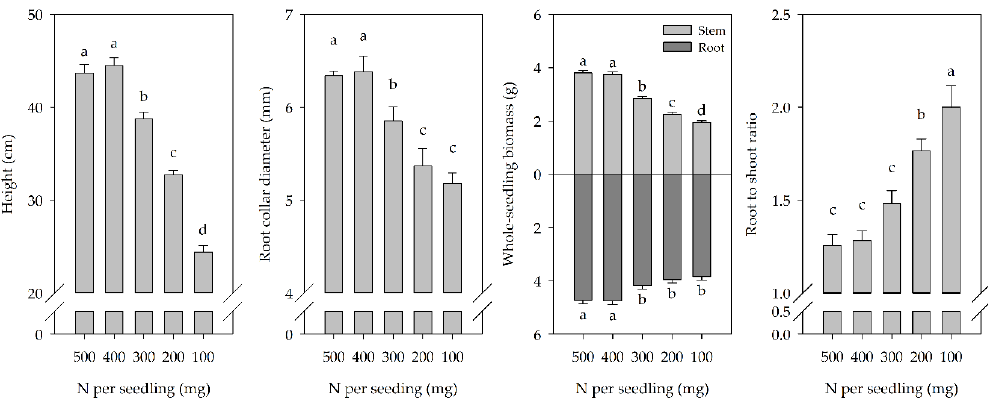
Figure 1. Seedling height, root collar diameter (RCD), whole-seedling (stem and root) biomass, and root to shoot ratio (R/S) (mean and standard error (SE)) of P. chinensis under specific nutrient treatments at the end of the growing season. Nitrogen fertilizer rates of 500 mg, 400 mg, 300 mg, 200 mg, and 100 mg were applied per seedling. Bars with different letters differ statistically according to Duncan’s test at α = 0.05.